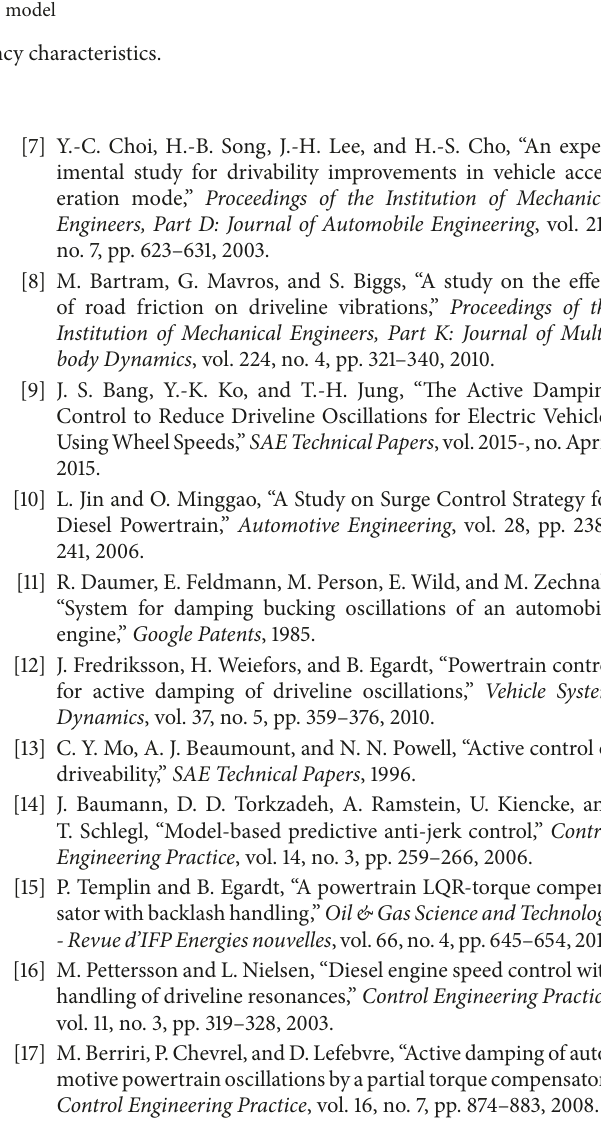
(b) Comparison between detailed model and two-degree-of-freedom model Figure 27: Frequency